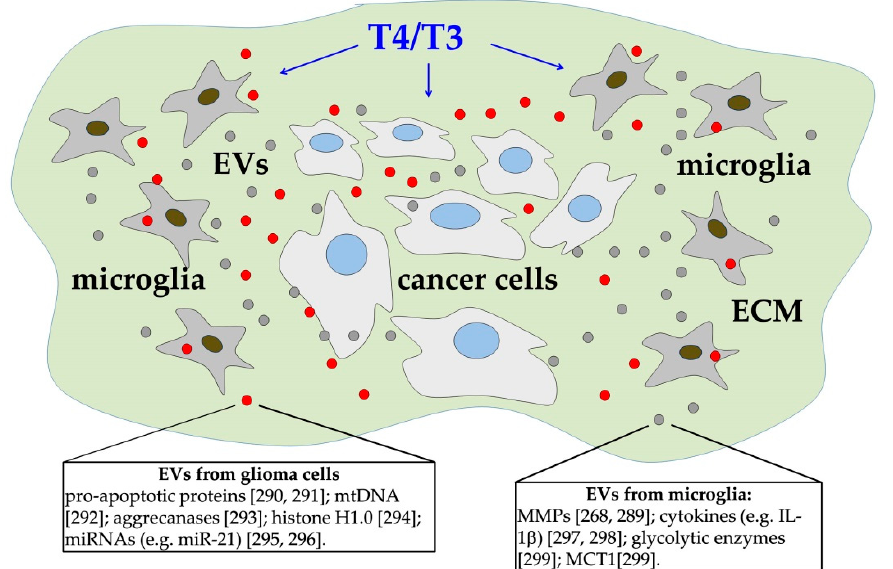
Figure 4. EV-mediated interactions among microglia and cancer cells. Extracellular matrix (ECM) of the glioma tissue is infiltrated by microglial cells, which seem to have a stimulating role in glioma progression. Both microglia and cancer cells produce extracellular vesicles (EVs), which contain different classes of molecules (e.g., proteins and different species of RNA) [268]. A few molecules, contained in EVs released from glioma cells (small red circles), and in EVs released from microglia (small grey circles), are reported in the rectangles, together with some relevant references [268,289–299]. MCT, monocarboxylate transporter; miRNAs, microRNAs; mtDNA, mitochondrial DNA; MMPs, matrix metalloproteinases. It has been suggested that THs (T4/T3) modulate brain cancer growth both directly and indirectly through their effects on microglia